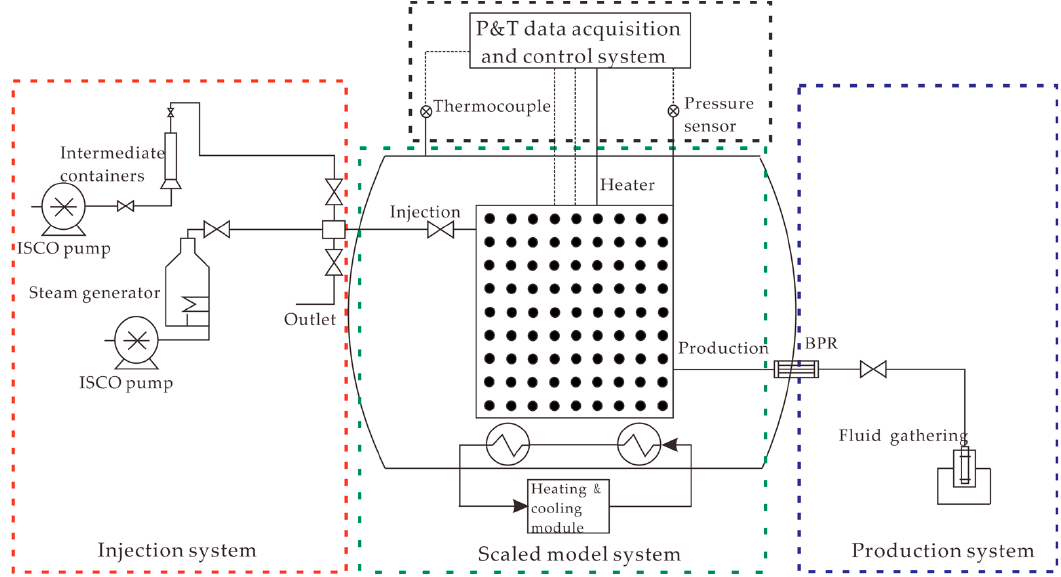
Energies 2022 , 15 , x FOR PEER REVIEW Figure 1. Schematic diagram of the 3-D scaled SAGD experiment. Figure 1. Schematic diagram of the 3-D scaled SAGD experiment.